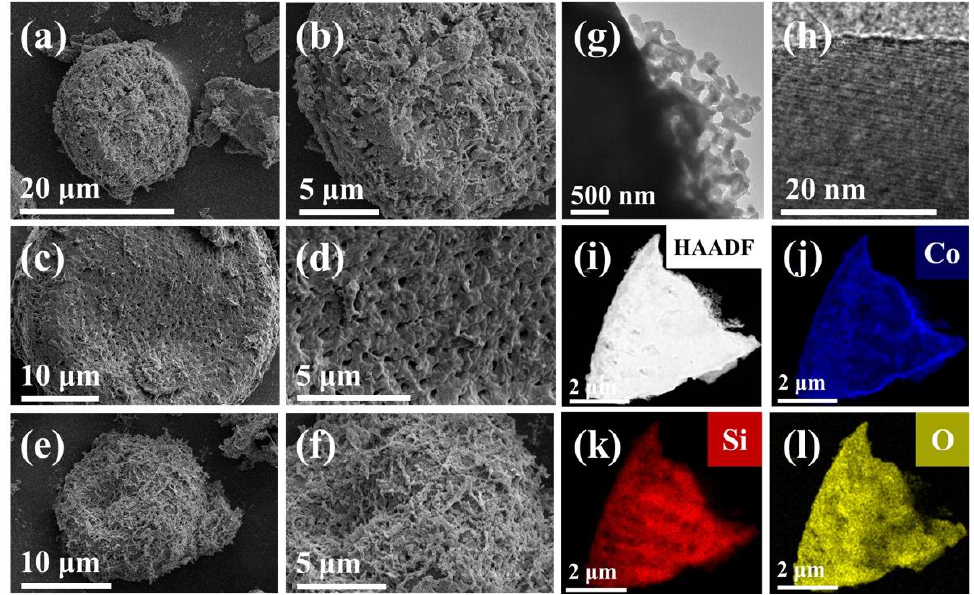
Figure 3. The SEM images of ( a , b ) Co 2 SiO 4 @DE-3, ( c , d ) Co 2 SiO 4 @DE-6, and ( e , f ) Co 2 SiO 4 @DE-12. The TEM images ( g – l ) of Co 2 SiO 4 @DE-6: ( g , h ) TEM mode, ( i ) HADDF mode, and ( j – l ) EDS mapping mode.